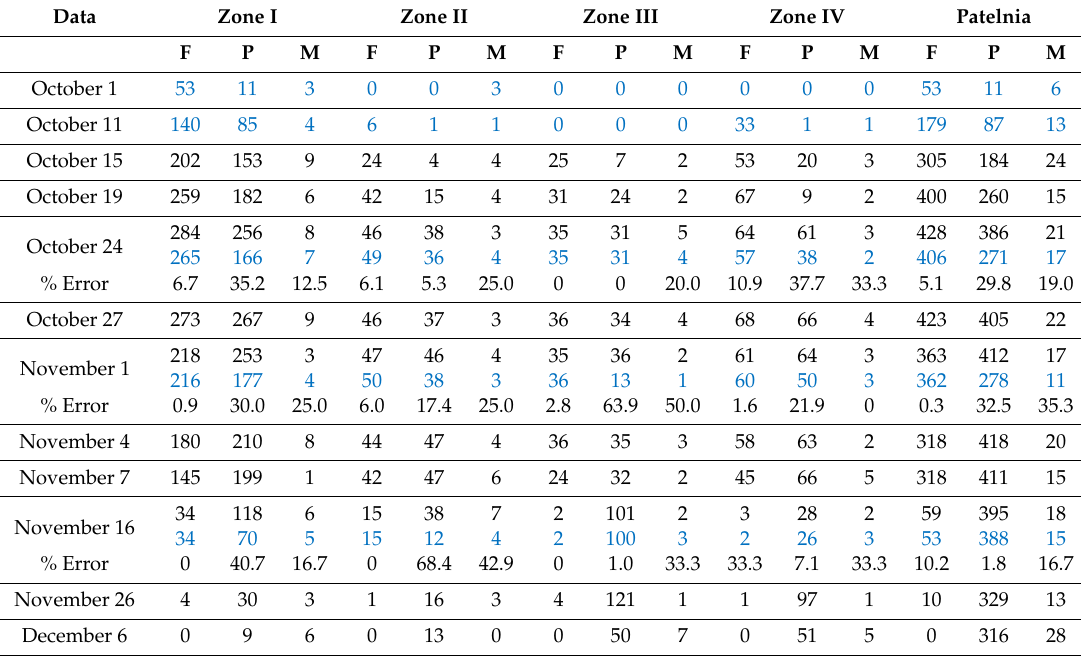
Figure 2. Locations of the cameras around the main harem in the study area ( A ); the first parturition recorded on September 26 by camera P1 ( B ); two bulls registered on October 23 by camera P2 ( C ); and view of the entire harem on November 7 by camera P3 ( D ). Table 2. Numbers of adult females (F), pups (P), and males (M) in different zones. Blue represents the results from ground counting.